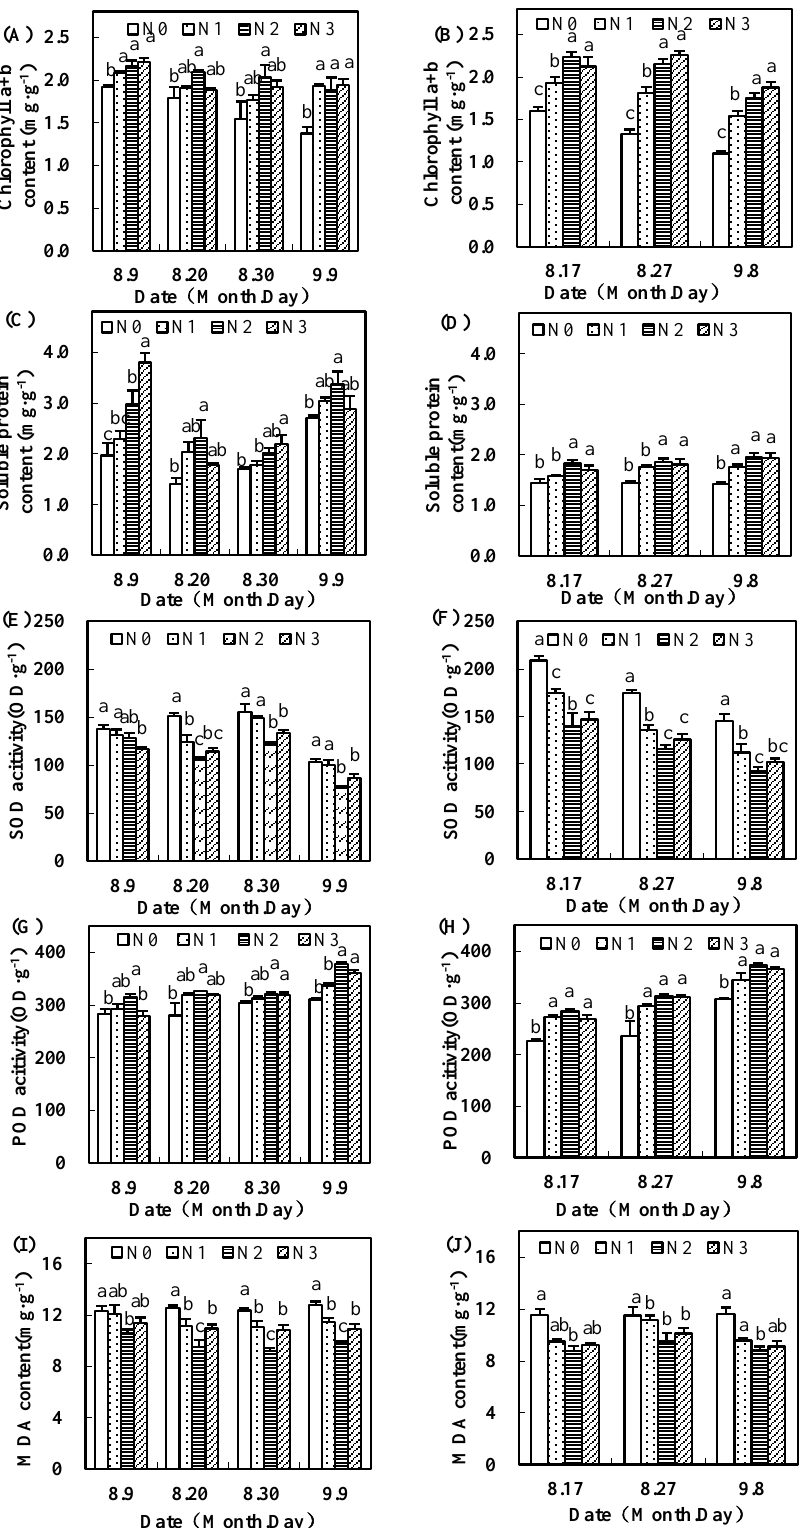
Figure 2. Effects of nitrogen fertilizer on chlorophyll a+b ( A , B ), soluble protein content ( C , D ), superoxide dismutase (SOD) activity ( E , F ), peroxidase (POD) activity ( G , H ), and malondialdehyde (MDA) content ( I , J ) in inner subtending leaves of cotton upper fruiting branches surveyed in the Yellow River Basin of China in 2011 and